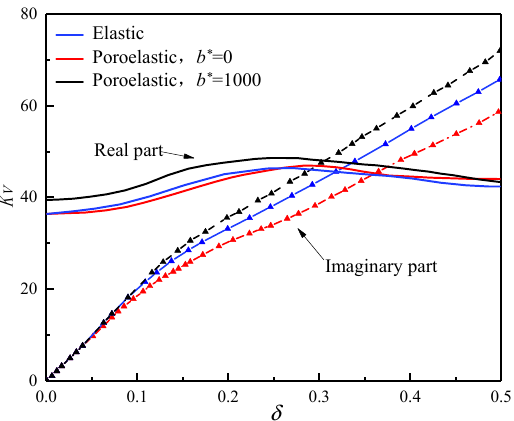
Figure 3. Influence of fluid viscosity and permeability of soil on pile impedance (reproduced from Zeng and Rajapakse (1999) [36]).